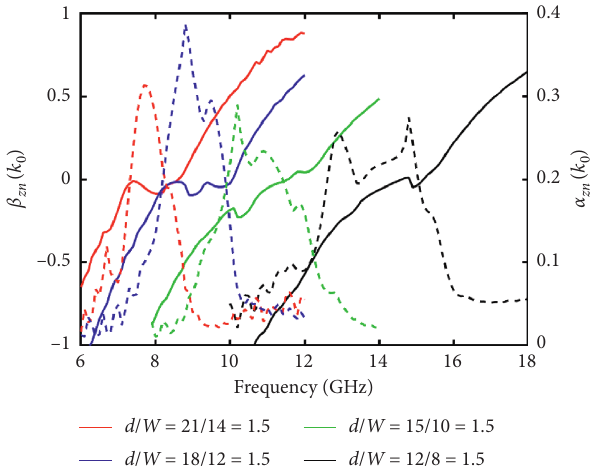
Figure 8: The normalized propagation constant of different pa- rameters when d / W � 1.5.